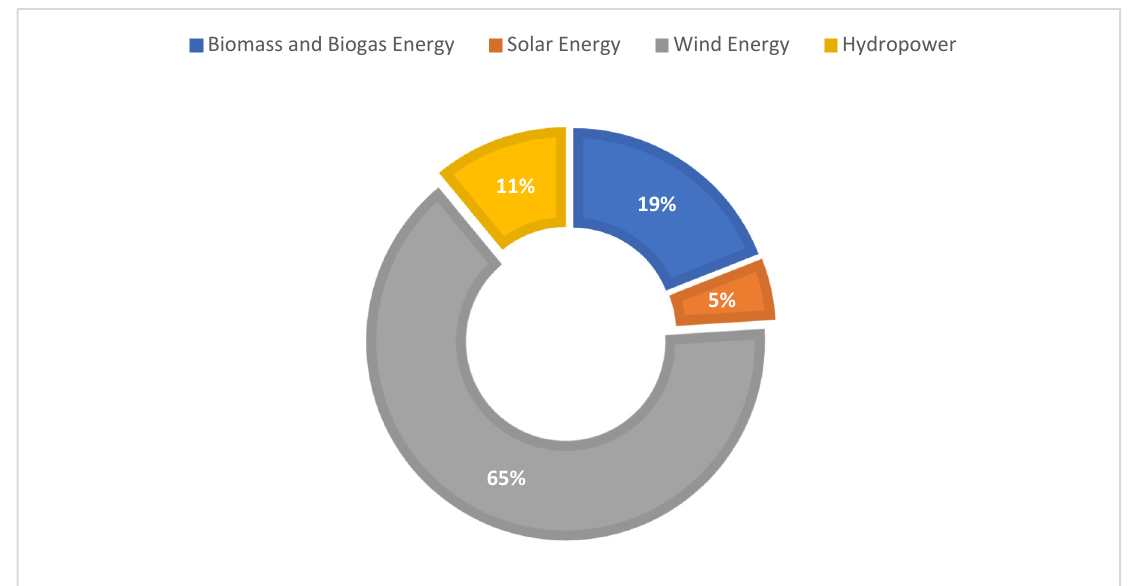
Figure 6. Poland’s share of individual capacity installed in 2019 [3].